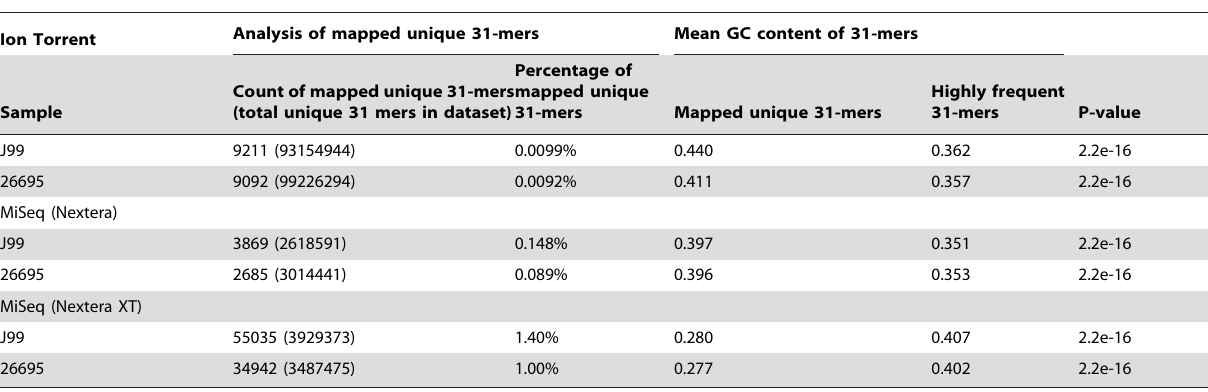
Table 2. Analysis of unique 31-mers that map to the references.